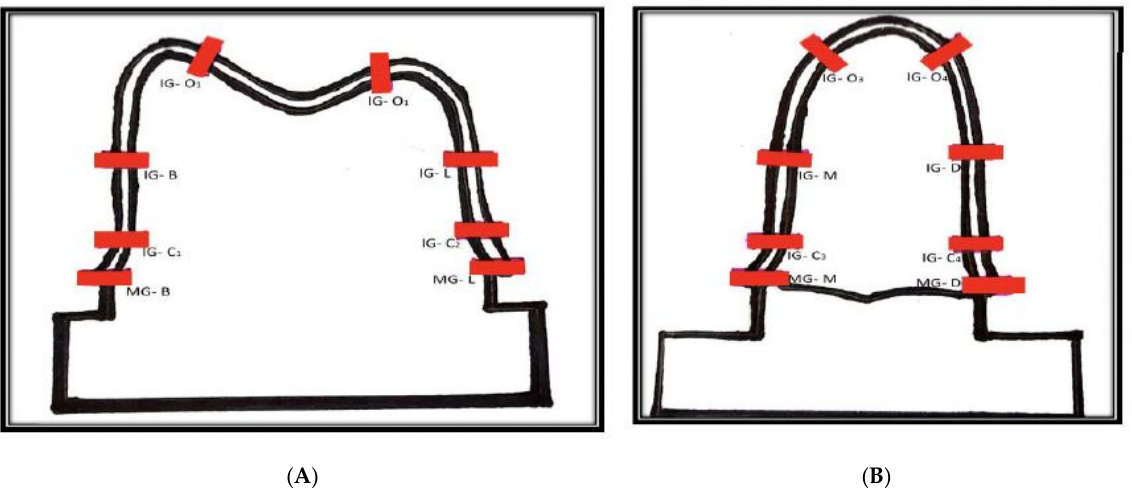
Figure 6 . ( A , B ): Line diagram showing the location of areas of measurements of the gap on ( A ). Buccolingual section, ( B ) Mesiodistal section.